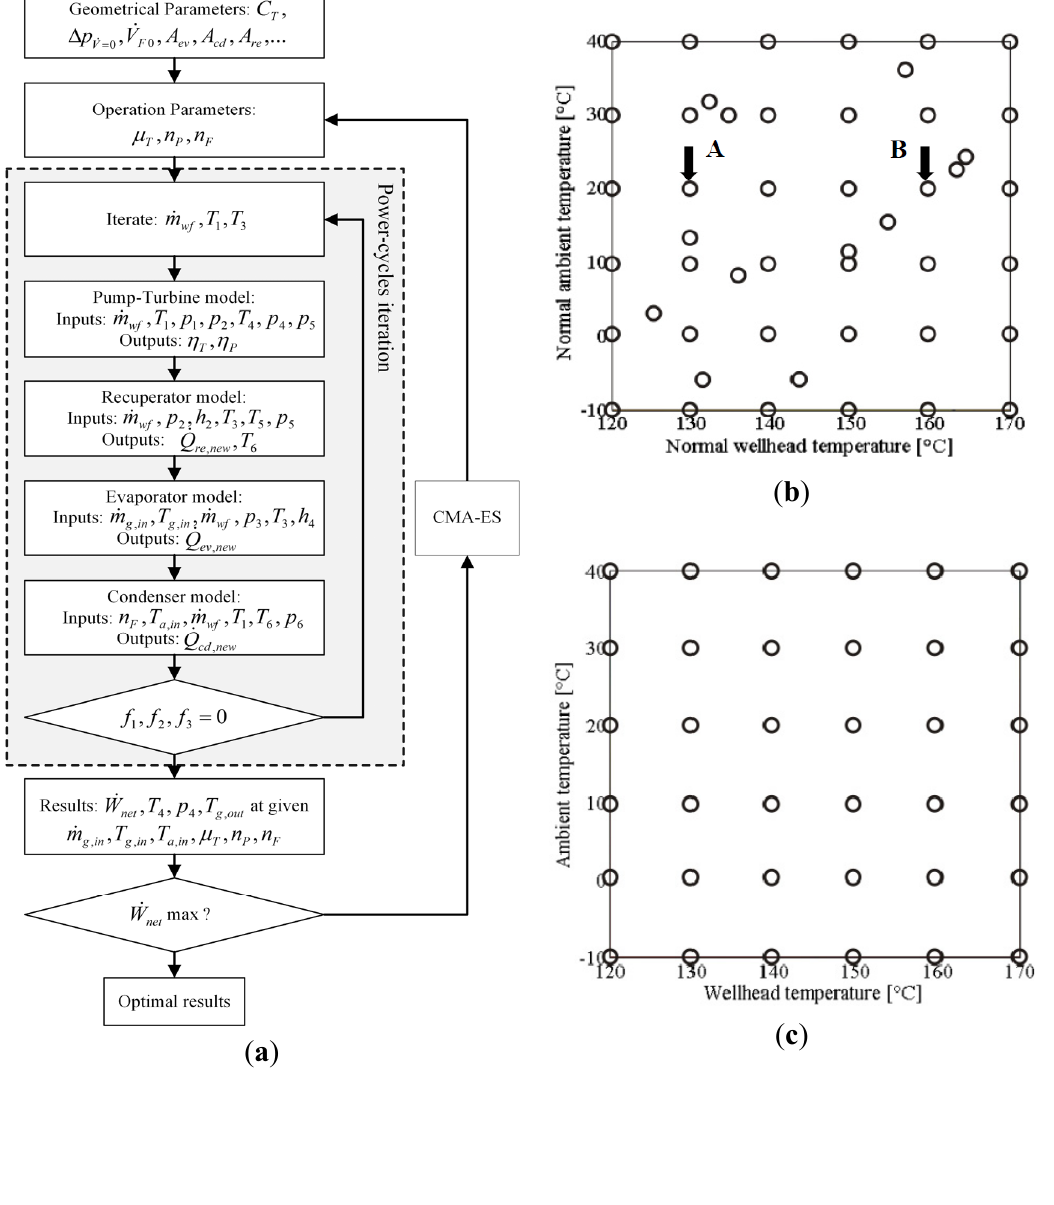
Figure 7. ( a ) Off-design optimization procedure for a design-point ( T